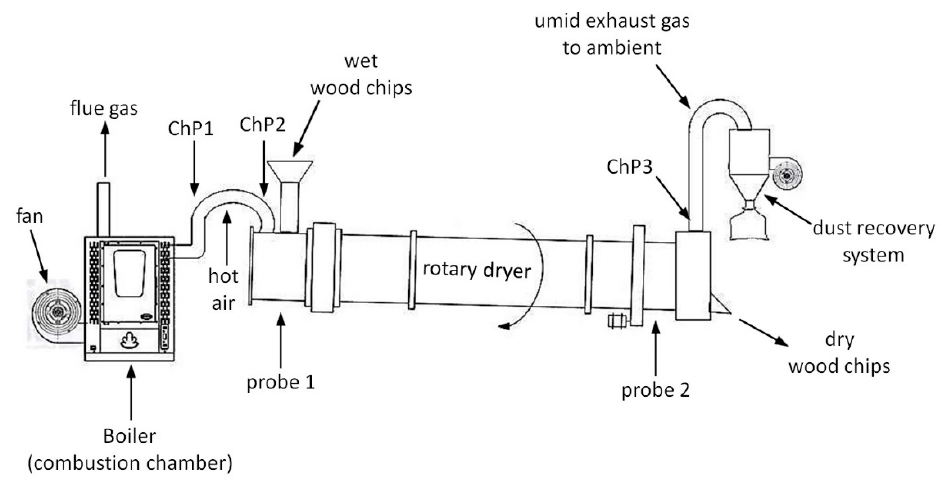
Figure 4. Schematic representation of the system and the points (checkpoint and probe) where the temperature and the airflow were recorded during the